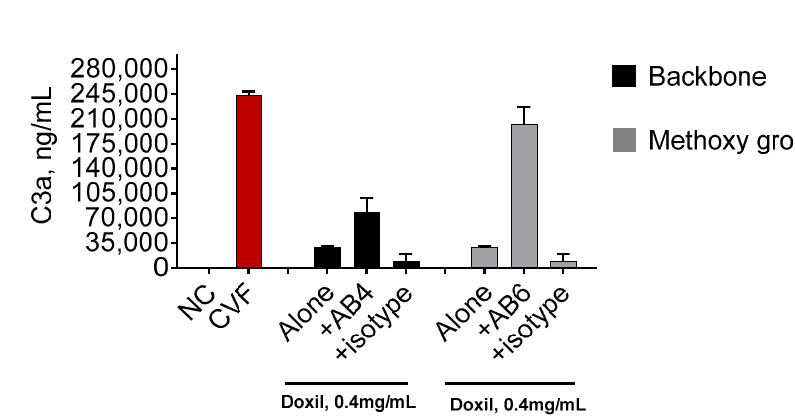
Figure 2. Influence of the anti-PEG antibodies on the complement activation by Doxil in murine plasma. Mouse plasma anticoagulated with hirudin was spiked with either Doxil or Doxil mixed with anti-PEG antibodies. The concentration of Doxil was 0.4 mg/mL of doxorubicin and was constant between all samples. The concentration of all antibodies was 10 μ g/mL. Complement activation was assessed by ELISA measuring levels of the murine C3a component of the complement. ( A ) Role of antibody class. Doxil mixed with a PEG-specific IgM (AB1, AB2, or AB7), regardless of the antibodies’ affinity, stimulated a higher level of complement activation than Doxil alone. Doxil combined with one PEG-specific IgG (AB4) stimulated a higher level of the complement activation than Doxil alone. Doxil mixed with two other PEG-specific IgG (AB3 or AB5) induced complement activation comparable to that induced by Doxil alone; ( B ) Role of epitope specificity. Doxil incubated with IgG reactive to the PEG backbone or IgG reactive to the PEG terminal methoxy group induced stronger complement activation than Doxil alone. However, in the presence of IgG specific to the methoxy group, the complement activation by Doxil was stronger than that in the presence of PEG backbone-reactive IgG. Mouse IgG and mouse IgM, as specified in the materials and methods, were used as isotype controls and did not show a physiologically significant (i.e., two-fold or higher) influence on the complement activation by Doxil. Each bar shows mean and standard deviation ( n = 3). All antibodies were in storage buffer containing 50% glycerol. When tested alone, 50% glycerol storage buffer did not result in C3a levels above those in the negative control (data not shown). DXR—doxorubicin; AB—